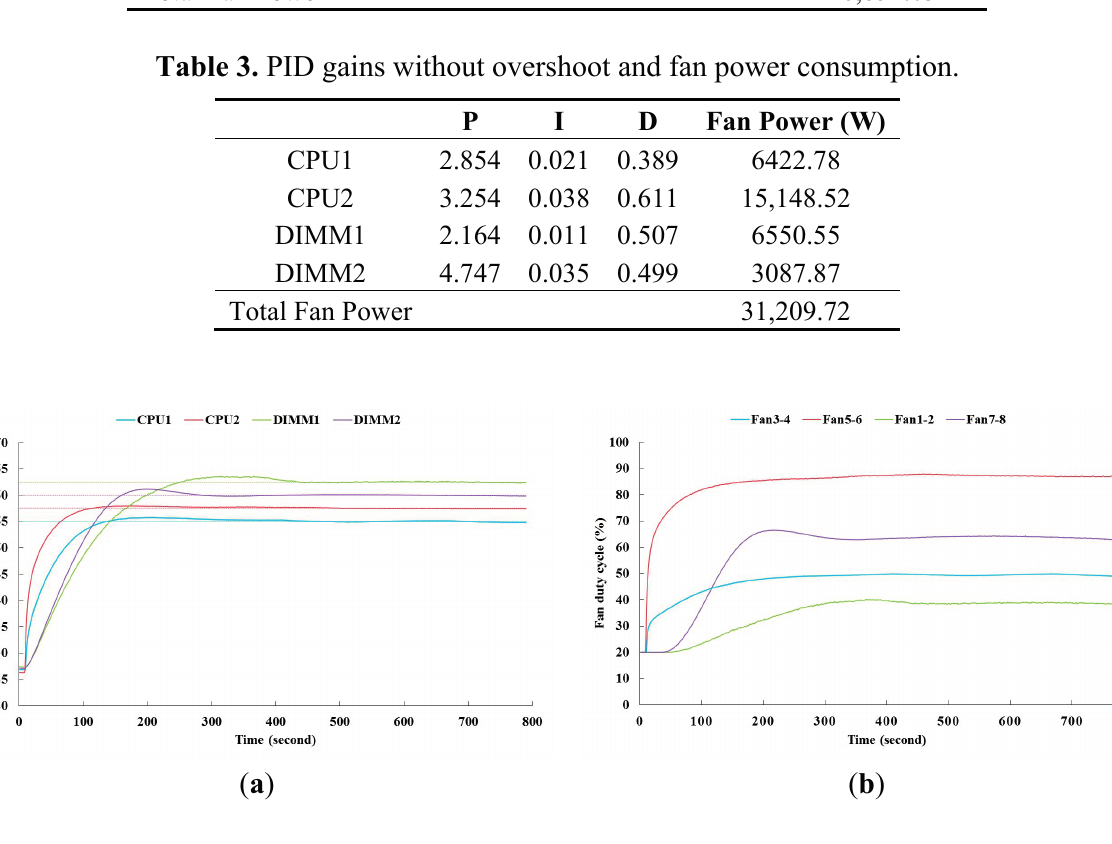
Figure 9. Control results of PID controllers with an overshoot. ( a ) The temperature responses of the electronic components by the PID controllers; ( b ) The control efforts of the fans by the PID